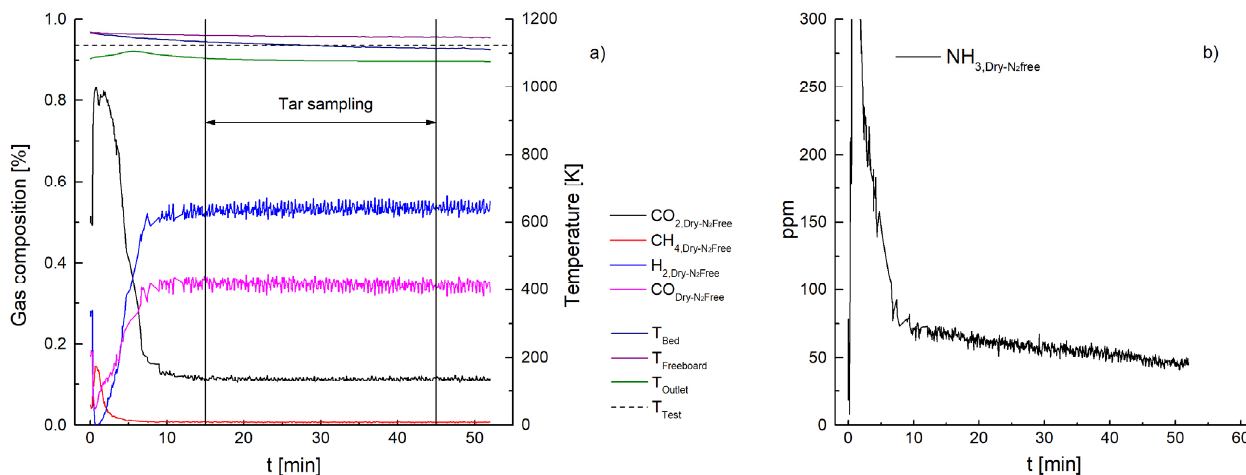
Figure A6. Temperature and gas composition ( a ) and ammonia content ( b ) during test 7.